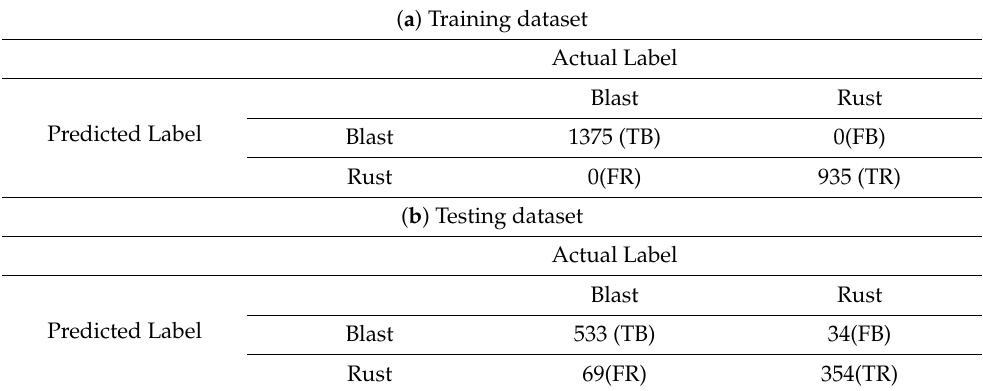
Table 4. Confusion matrix of pre-trained ‘Custom-Net’